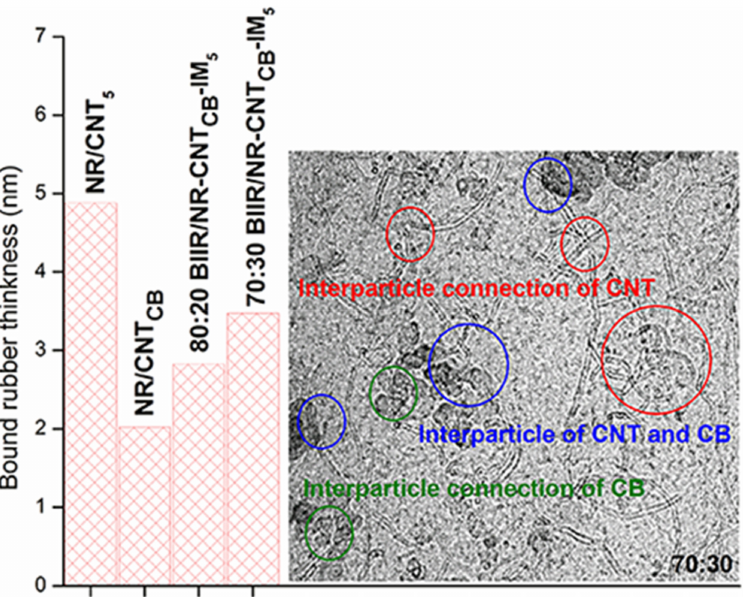
Figure 8. Relation of bound rubber thickness of the BIIR/NR-CNT CB composites filled with IM, BIIR:NR ratios of 70:30 and